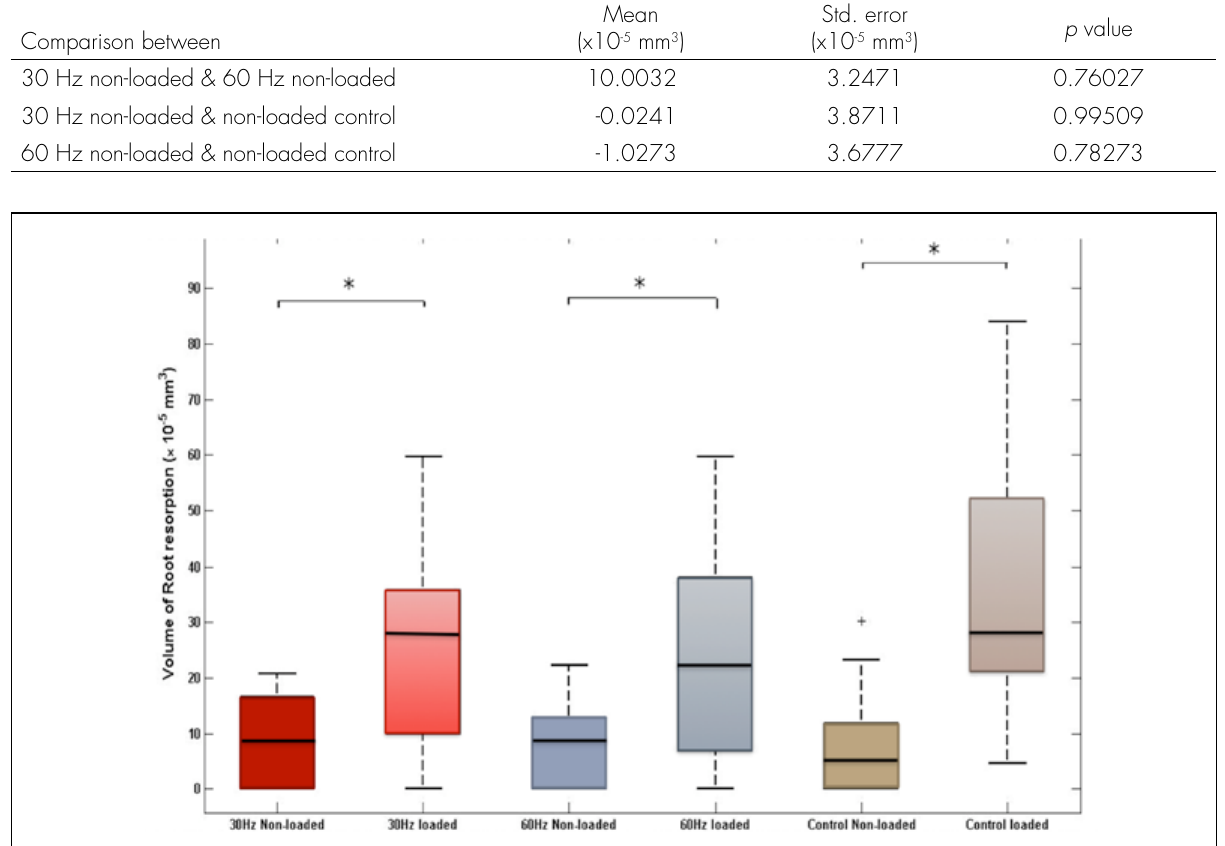
Figure 4. Box plot shows comparison of the volume of root resorption between groups